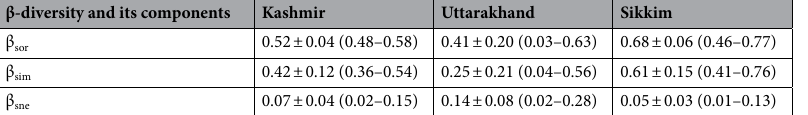
Table 4. Mean (± standard deviation) of β-diversity (β sor ) and its turnover (β sim ) and nestedness (β sne ) components in Kashmir, Uttarakhand and Sikkim Himalayan transects. Values in parentheses represent the range.